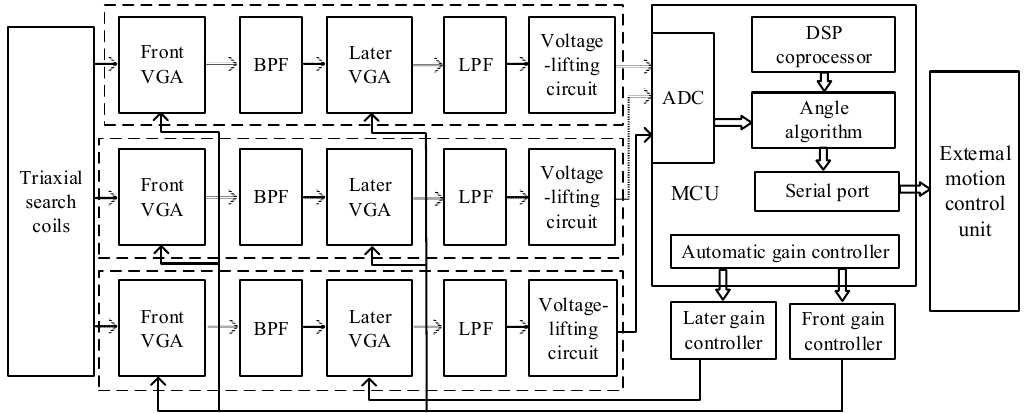
Figure 9 . Diagram of the signal conditioning and processing subsystem (BPF: Band-pass filter; VGA: Variable gain controller; LPF: Low-pass filter).